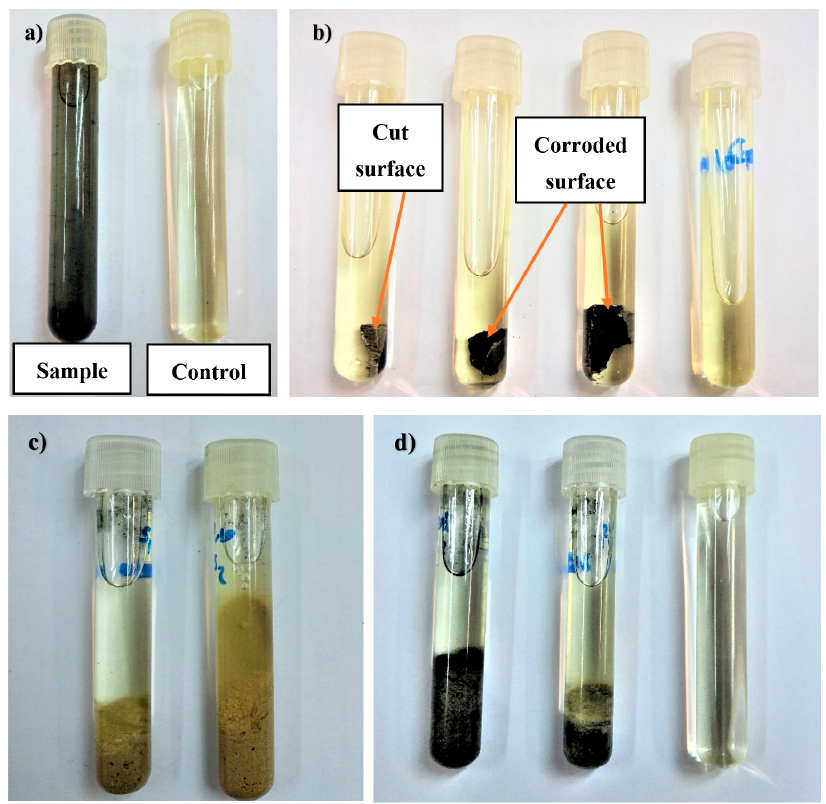
Figure 11. SRB growth monitoring in specific media after 20 days. Control: The specific medium without inoculation. ( a ) Surface scratch from corrosion tube, ( b ) the corrosion tube cuts ( c ) the soil samples of corrosion area after five days, and ( d ) after 20 days.